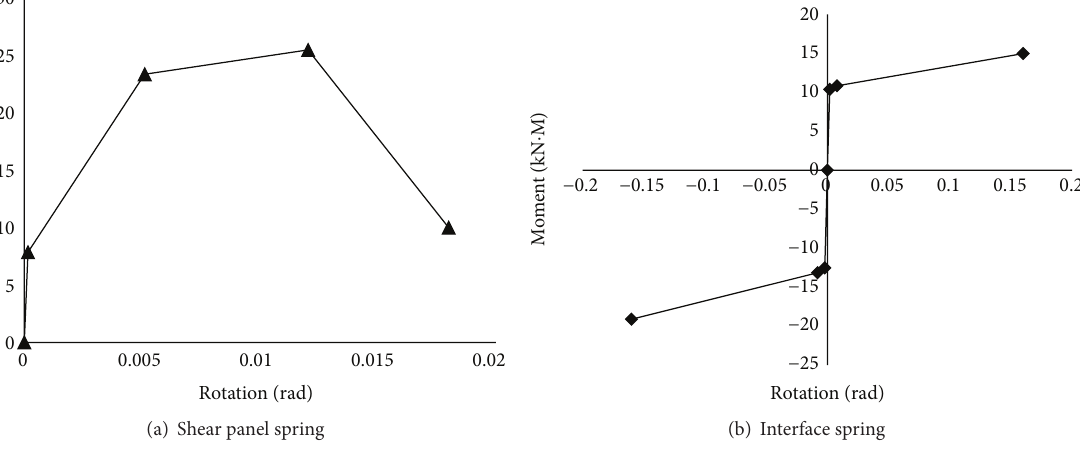
Figure 15: Spring properties of joint element for the scaled specimen.